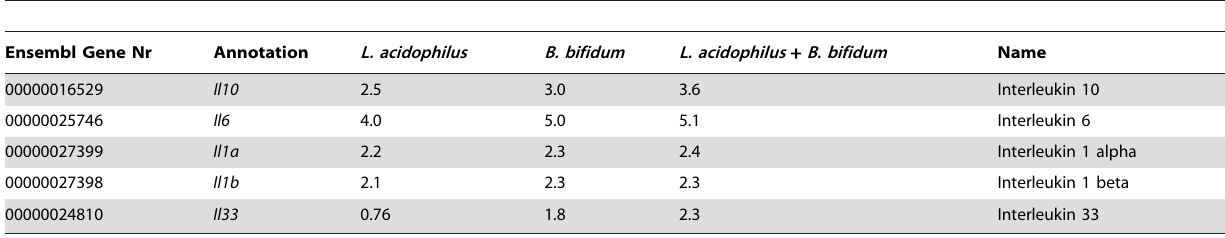
Table 5. Additive Effects of Bifidobacterium bifidum Z9 on the Cytokine Expression in Lactobacillus acidophilus NCFM stimulated Dendritic Cells.